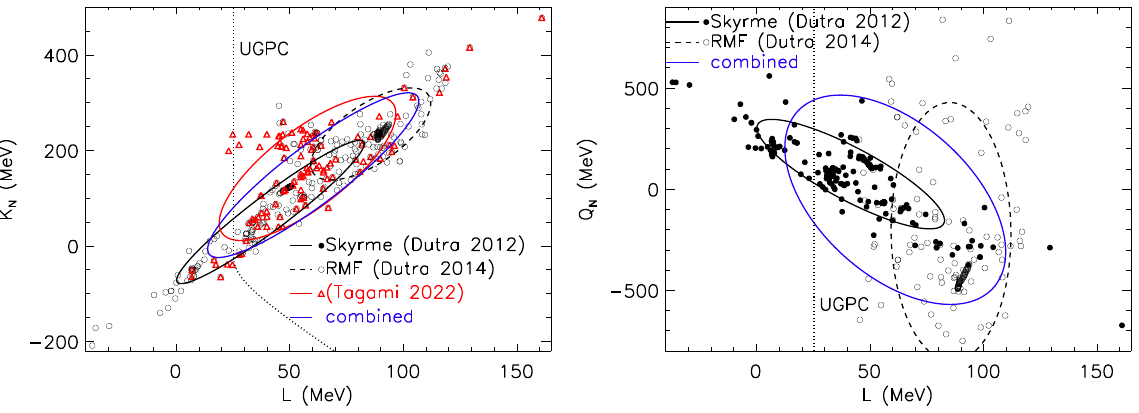
Figure 2. The same as Figure 1 but for correlations between K N and L [ left panel ] and Q n and L [ right panel ]. The Unitary Gas Pressure Conjecture restricts allowable regions to the right of the dotted lines labelled